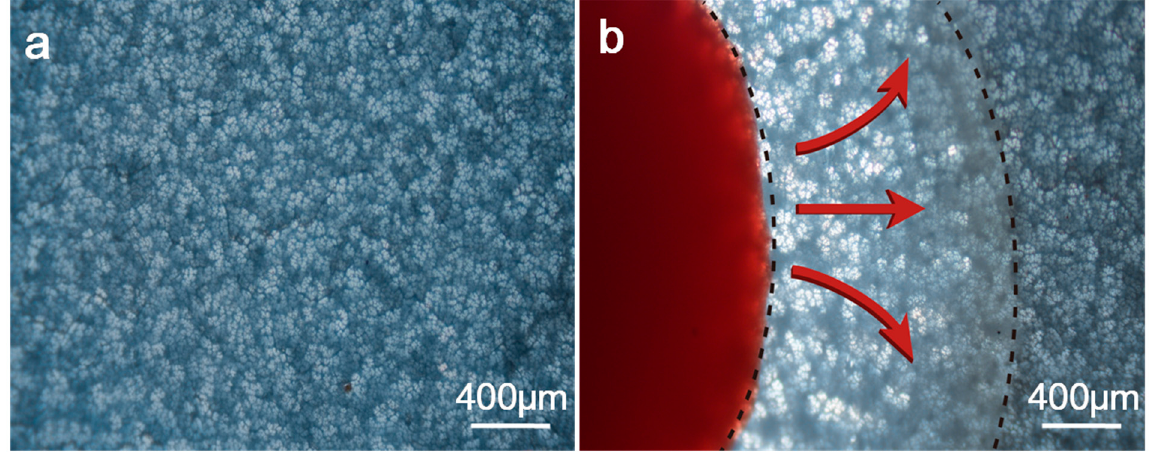
Figure 3. Zoom-stereo microscope images of ( a ) CA@PEG-2000 membranes and ( b ) 5 μ L of whole blood separated by CA@PEG-2000 membranes.